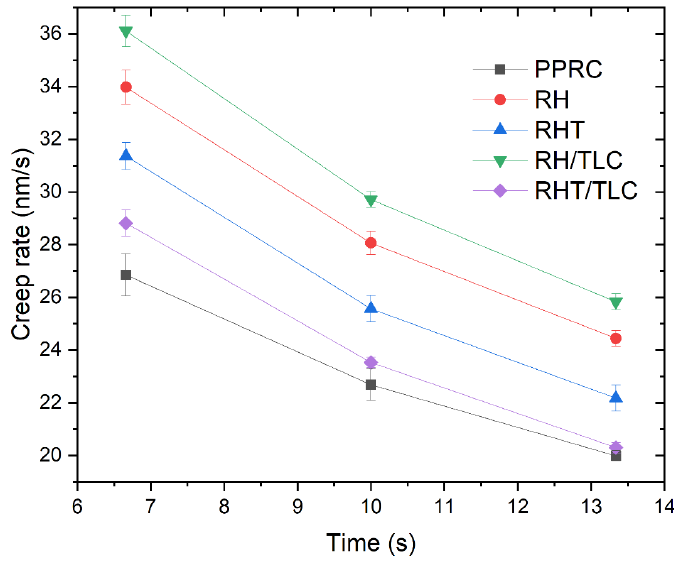
Figure 8. Creep rate as a function of time for different